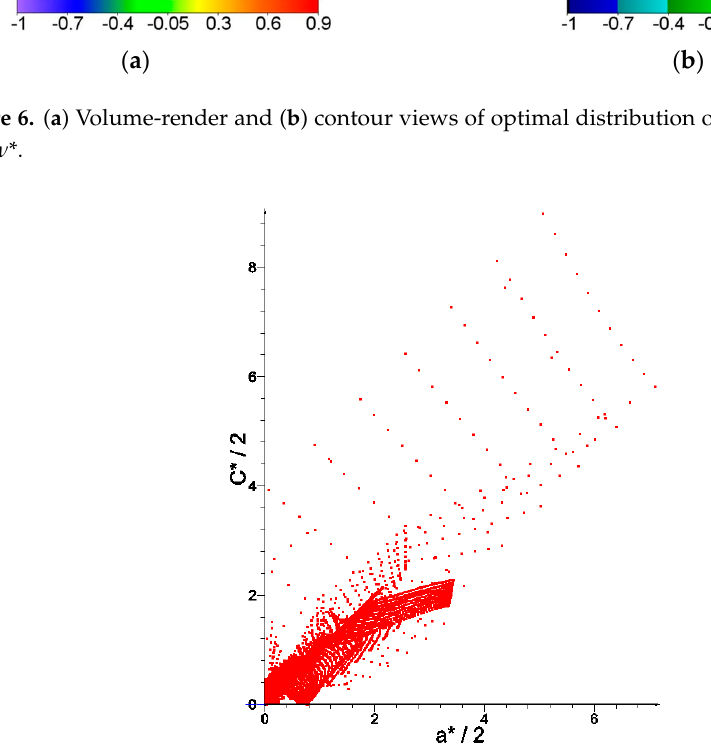
Figure 7. Distribution of optimal pairs of points ( a */2, c */2).